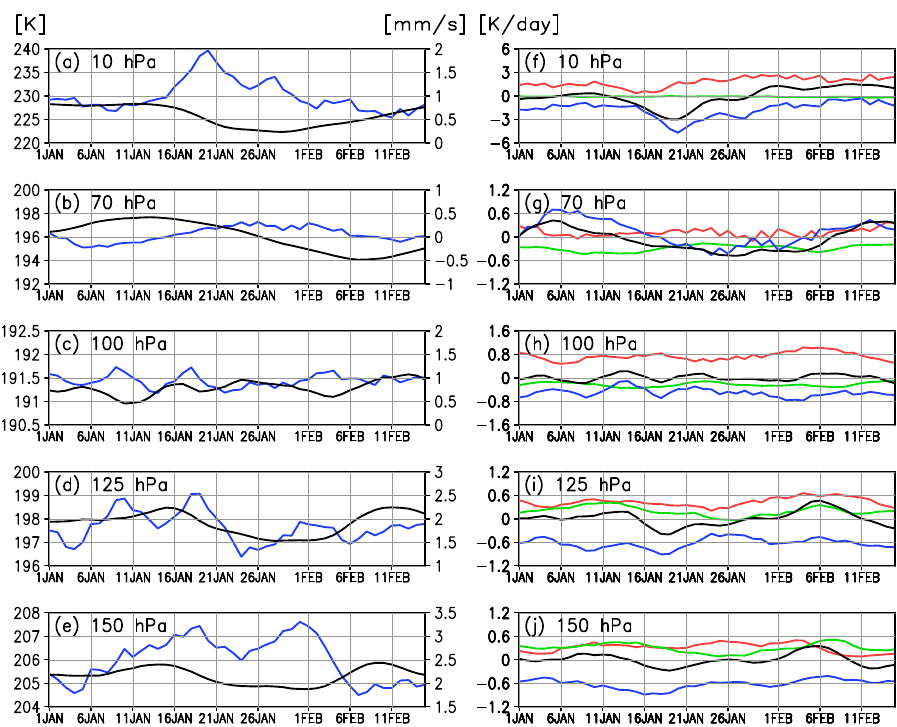
Fig. 2. Time series of (left) zonal-mean temperature (K; black lines), residual mean vertical wind (mms − 1 ; blue lines), and (right) major terms in the transformed Eulerian mean (TEM) thermodynamic equation averaged over 10 ◦ S–10 ◦ N (Kd − 1 ) . (a, f) 10hPa, (b, g) 70hPa, (c, h) 100hPa, (d, i) 125hPa, and (e, j) 150hPa. The terms in the TEM thermodynamic equation consist of potential temperature change (black lines), vertical advection (blue lines), vertical convergence of vertical heat flux (green lines), and diabatic heating (red lines). Other terms are not shown. Data are smoothed using a 5-day running average.